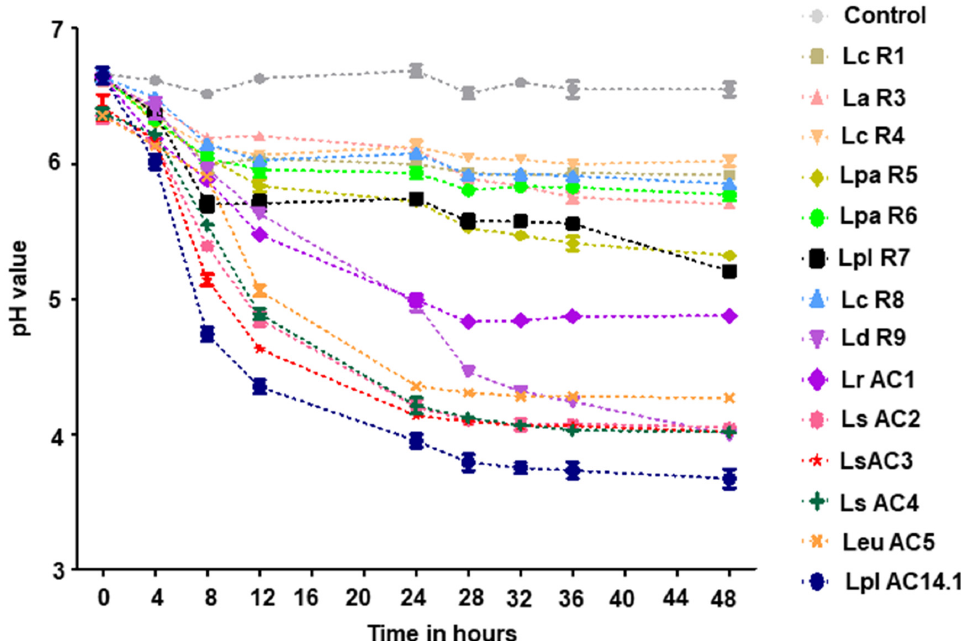
Figure 8. Changes in pH of the soymilk fermented by different LAB isolates. n = 2. Lc, L. casei; La, L. acidophilus; Lpa, L. paracasei; Lpl, L. plantarum; Ld, L. delbrueckii; Lr, L. rhamnosus; Ls, L. sakei; Leu, Leu. mesenteroides.